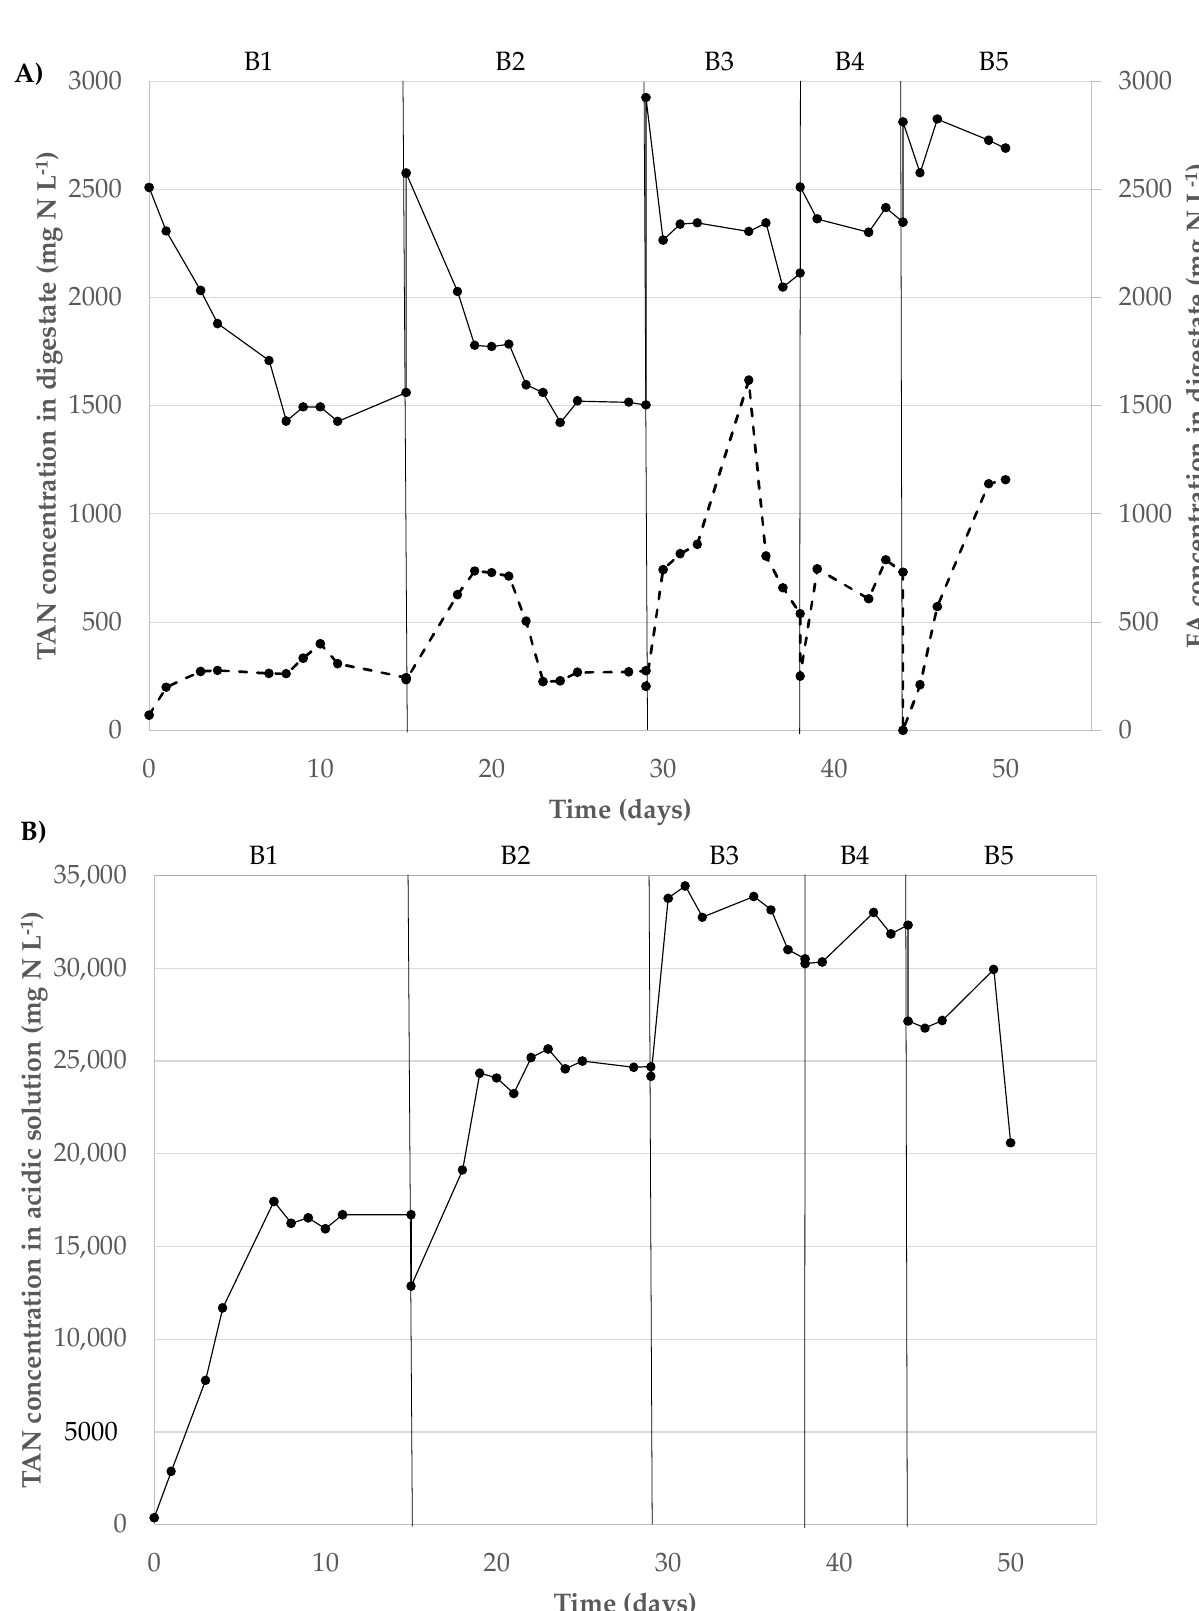
Figure 5. TAN (continuous line) and FA (dashed line) concentration in the digestate ( A ) and TAN concentration in the acidic trapping solution ( B ) in the fed-batch assay (Experiment II).